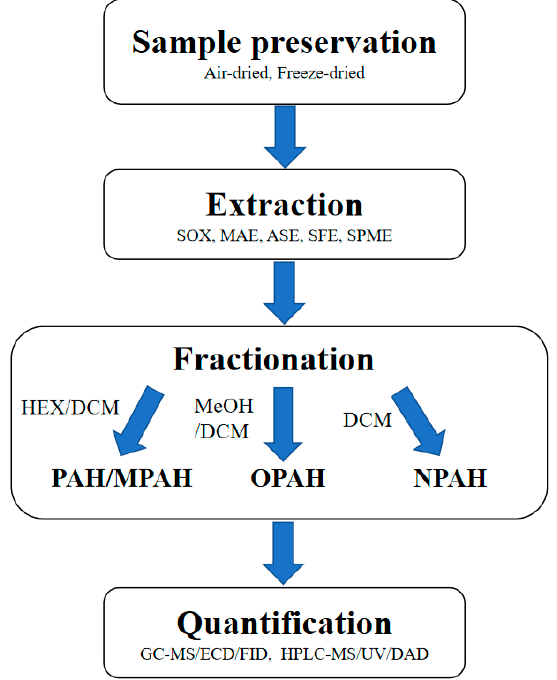
Figure 2. Analysis and detection procedures of polar PAHs.